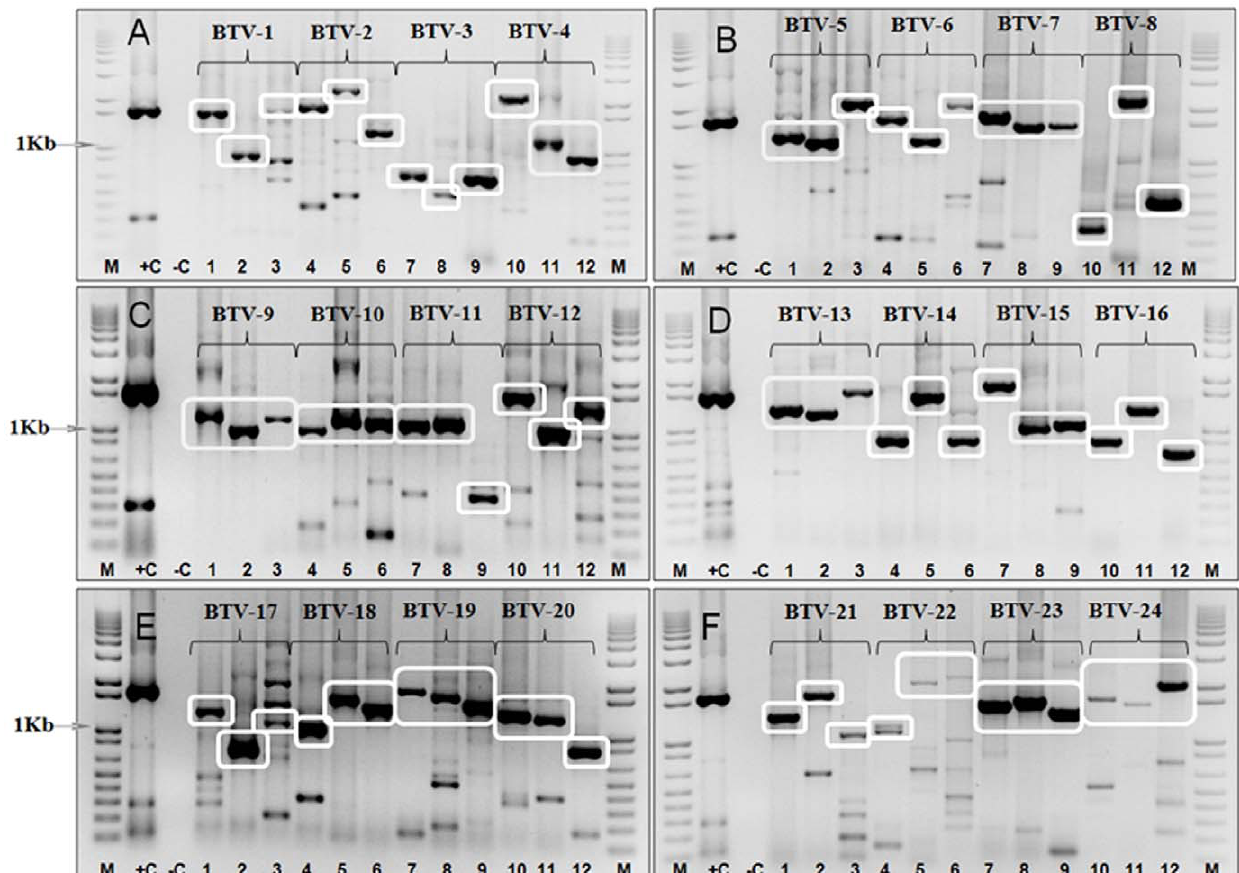
Figure 1. Electrophoretic analysis of cDNA products from Seg-2 of BTV reference strains using ‘type-specific’ primer-pairs for individual serotypes (Panels A–F). Panel A: PCR amplicons were generated from Seg-2 of BTV-1/RSArrrr/01 using primer-pairs ‘1A1’ 2 1621